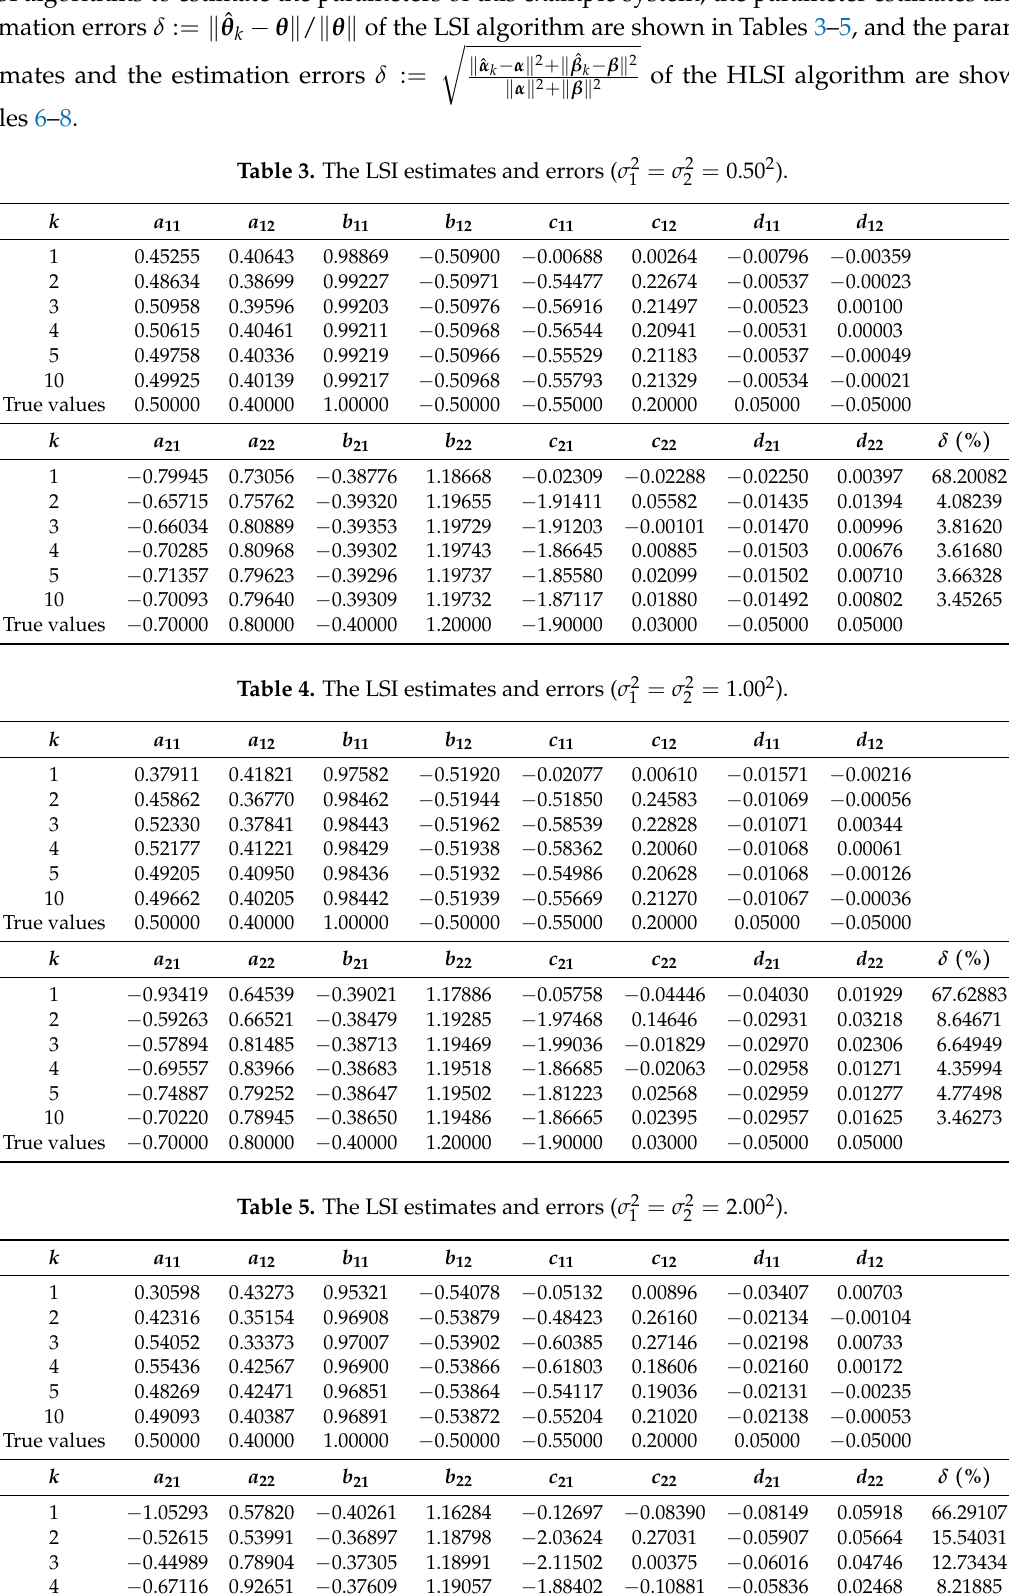
Table 3. The LSI estimates and errors ( σ 2